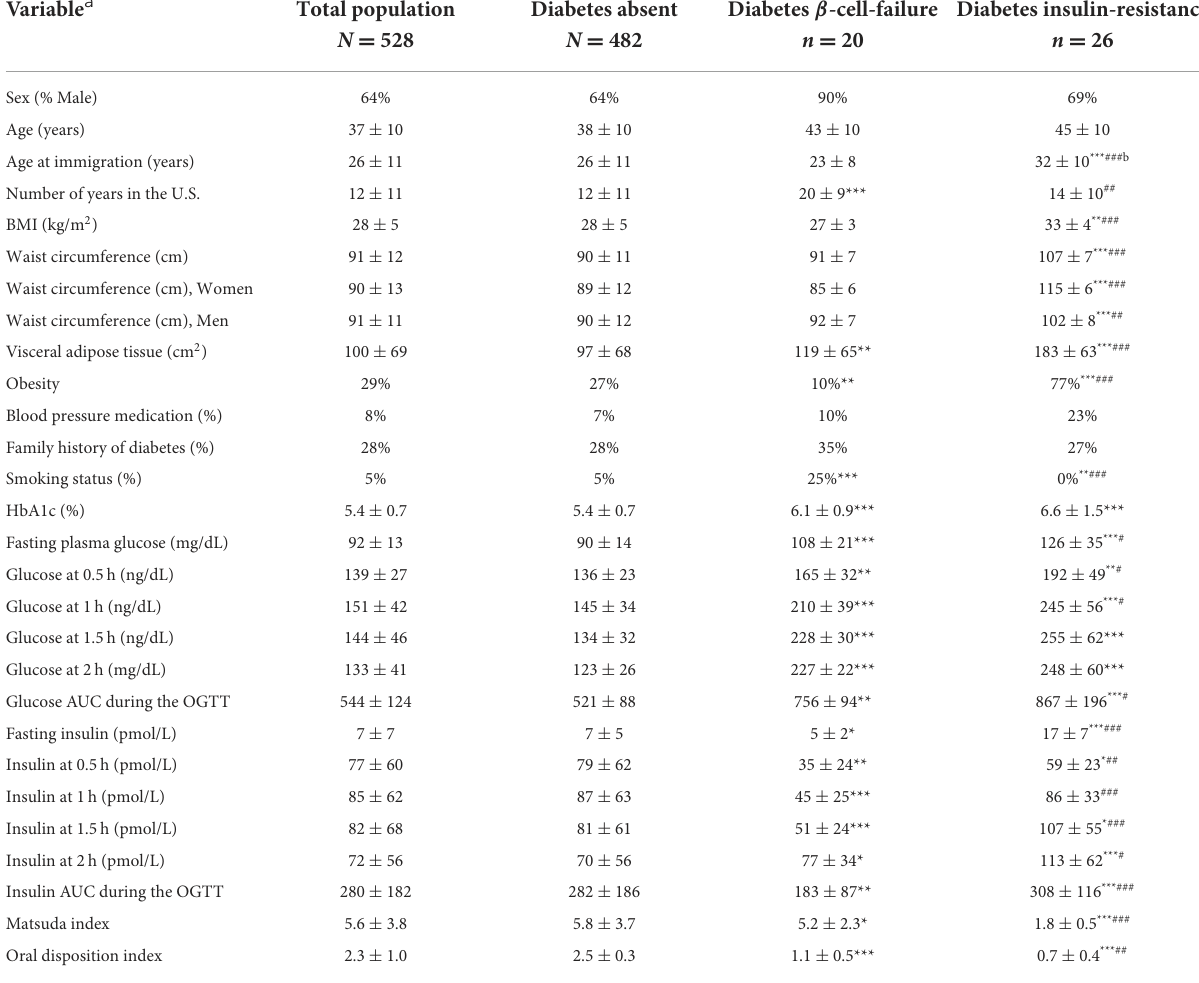
TABLE 2 Population characteristics in diabetes-absent and diabetes etiology groups. Variable